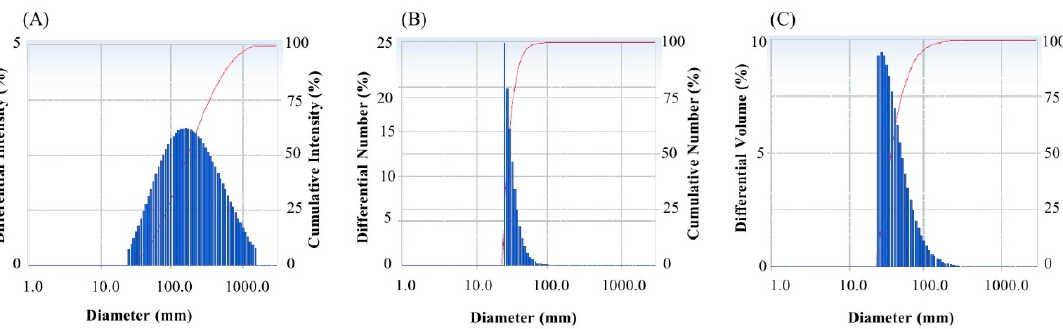
Figure 5. Fourier-transform infrared spectroscopy (FTIR) spectra of synthesized silver nanoparticles.